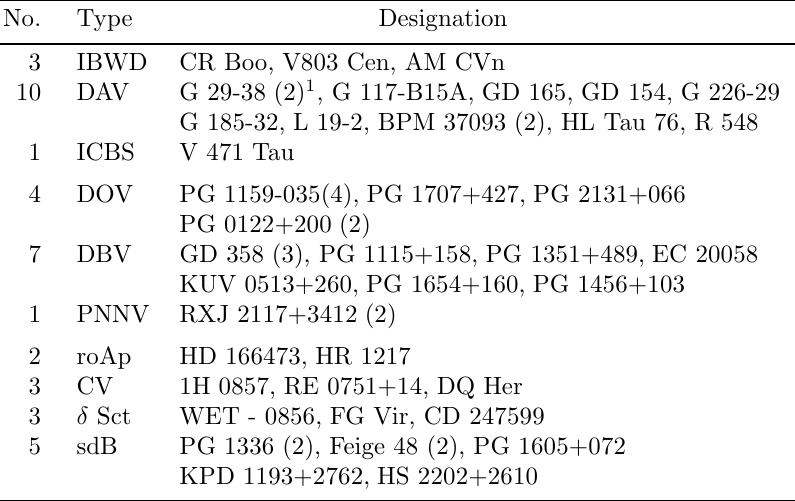
Table 2. Objects observed during the WET